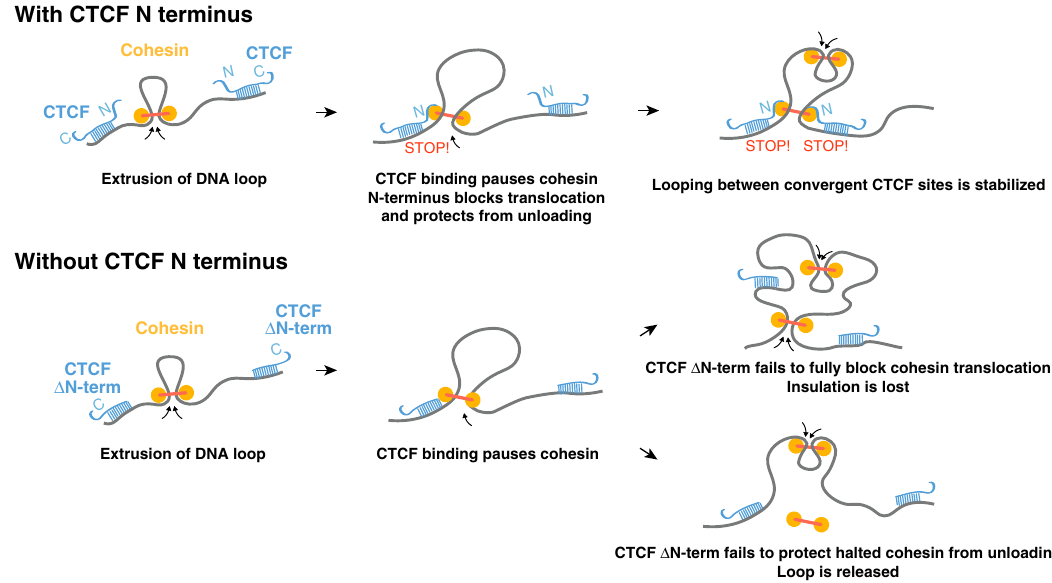
Fig. 6 Summary model for the role of the CTCF N terminus in chromosome folding. Upon encountering a bound CTCF site, cohesin halts, irrespective of motif orientation 18,72 . Because of the nonpalindromic nature of the CTCF DNA motif, the effect of the CTCF N terminus on cohesin retention and DNA loop stabilization is polarized to one side of CTCF-binding site. Altogether, these events result in pairs of interacting TAD boundaries being preferentially populated by CTCF motifs in convergent orientation. Upon deleting the N terminus of CTCF, cohesin occupancy is diminished but still detectable, indicating that cohesin still pauses upon encountering bound CTCF sites. Loss of cohesin occupancy may re fl ect either or both decreased ability of truncated CTCF to block cohesin (leading to insulation defects) and decreased ability of truncated CTCF to protect halted cohesin from unloading (leading to loss of the DNA loop). See Supplementary Fig.